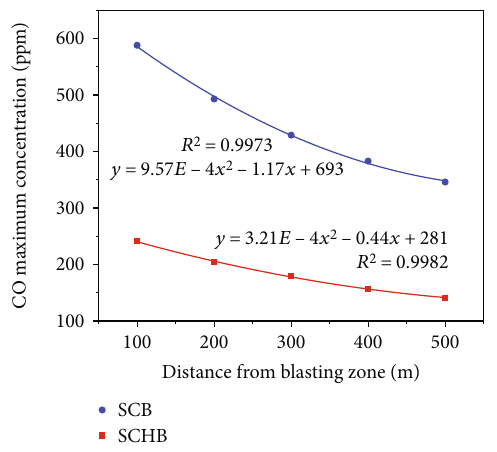
Figure 19: Changes in maximum CO concentration with monitoring distance in four-hole SCB and SCHB.